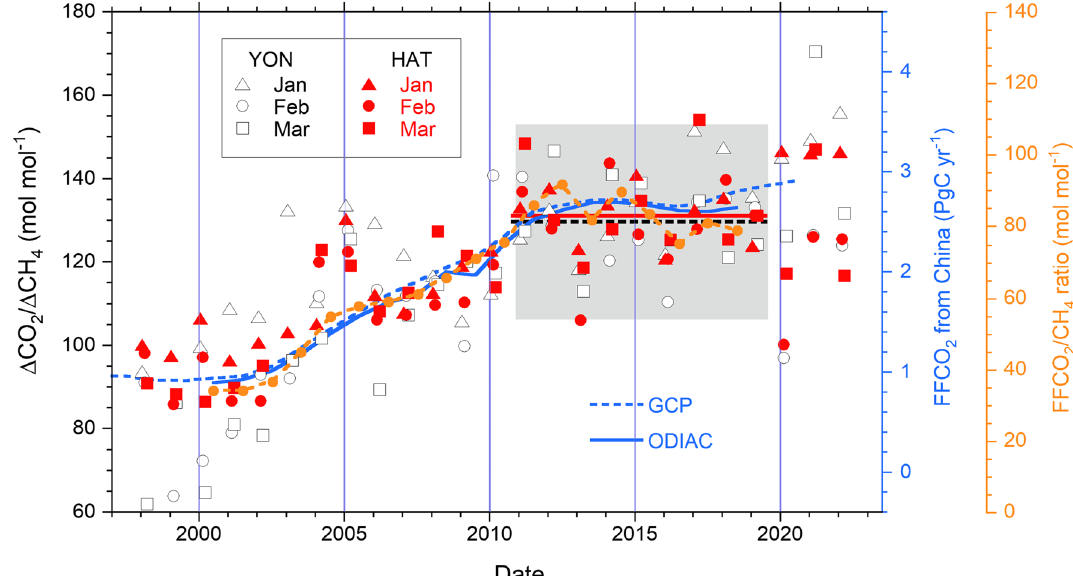
Fig. 3 Temporal changes in the monthly ΔCO 2 /ΔCH 4 ratios based on the observations at HAT and YON. The monthly averages at HAT (closed red symbols) and at YON (open black symbols) for January (triangles), February (circles), and March (squares) from 1998 to 2022 are plotted. Solid red and dashed black lines represent the average values of the monthly ΔCO 2 /ΔCH 4 ratios during a 9-year period (2011–2019) for HAT and YON, respectively. The gray-shaded area represents the 95% confidence interval for the average for YON. The dashed and solid blue lines represent the FFCO 2 emissions from China (right blue Y-axis) taken from GCP (Friedlingstein, et al. 2022) and ODIAC (Oda et al. 2018), respectively. The orange circles connected with the dashed orange line represent the temporal change in the FFCO 2 /CH 4 emission ratios, which were averages based on the emissions from China used in the model simulation in this study (Additional file 1: Fig. S1) for the 3